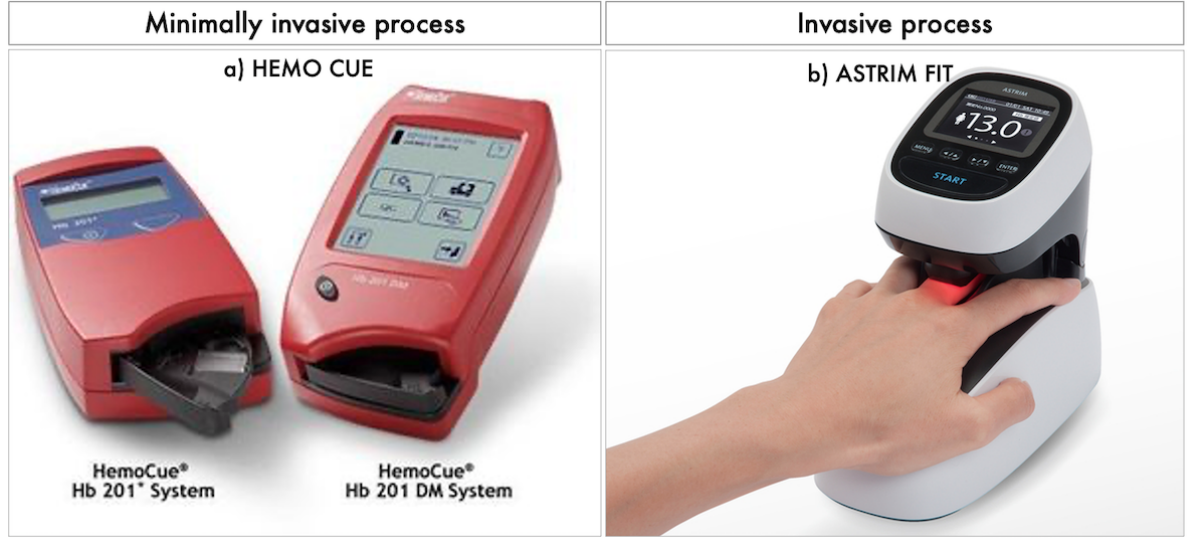
Figure 1. Point-of-care tools for minimally invasive and noninvasive hemoglobin measurement: (a) Hemo Cue, and (b) Astrim-Fit. (These two photos are licensed under CC BY-ND).